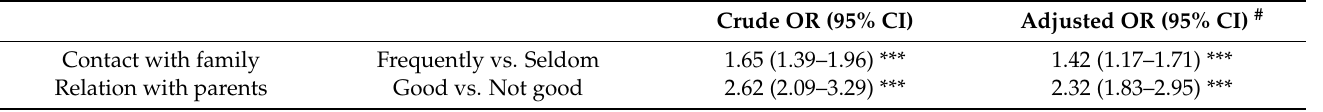
Table 3. Odds ratio (95%CI) of college student happiness for family factors ( n = 2186). Crude OR (95% CI) Adjusted OR (95% CI) # Contact with family Frequently vs. Seldom Relation with parents Good vs. Not